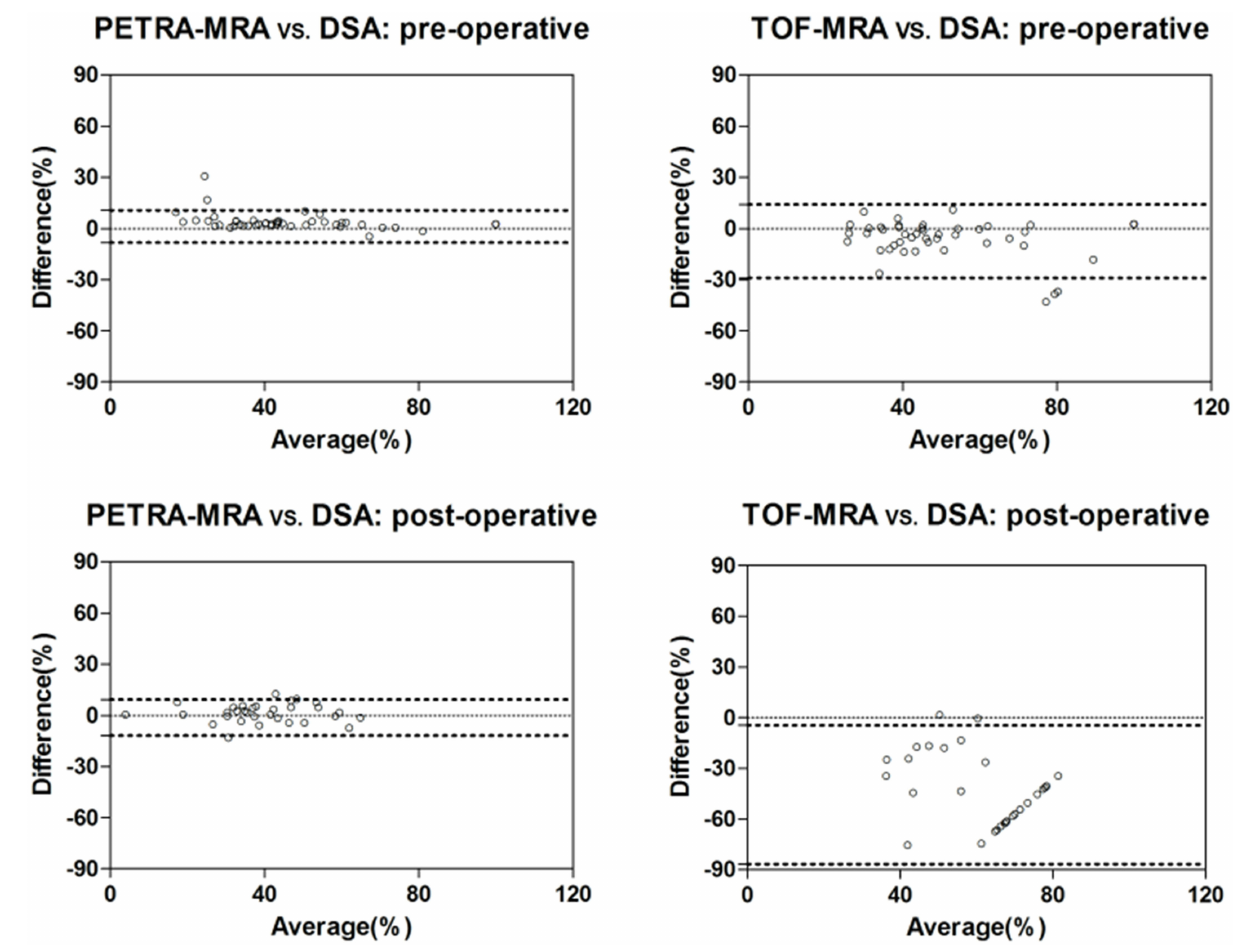
FIGURE 2 | Bland-Altman plots for the comparisons of stenosis measurements between PETRA-MRA/TOF-MRA and reference standard